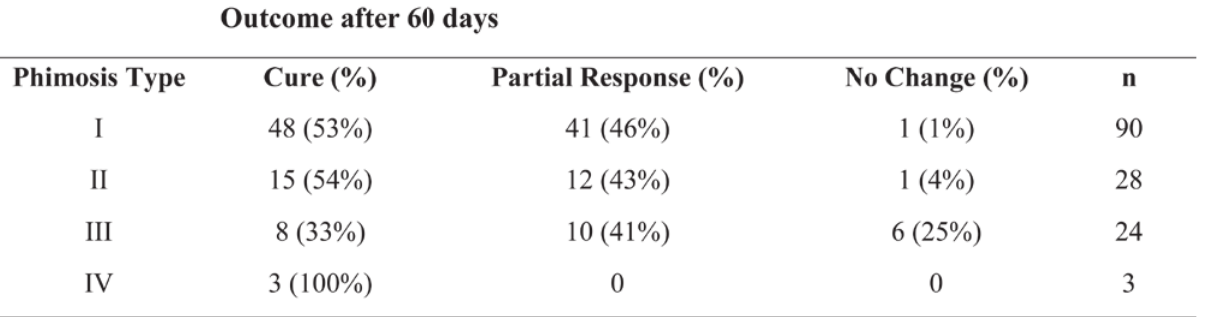
Table 4 - Outcome according to pre-treatment phimosis